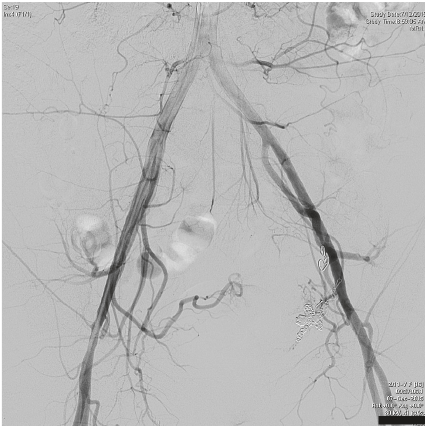
Figure 7: Pelvic angiogram following serial embolisation shows no persisting abnormal uterine vessels.